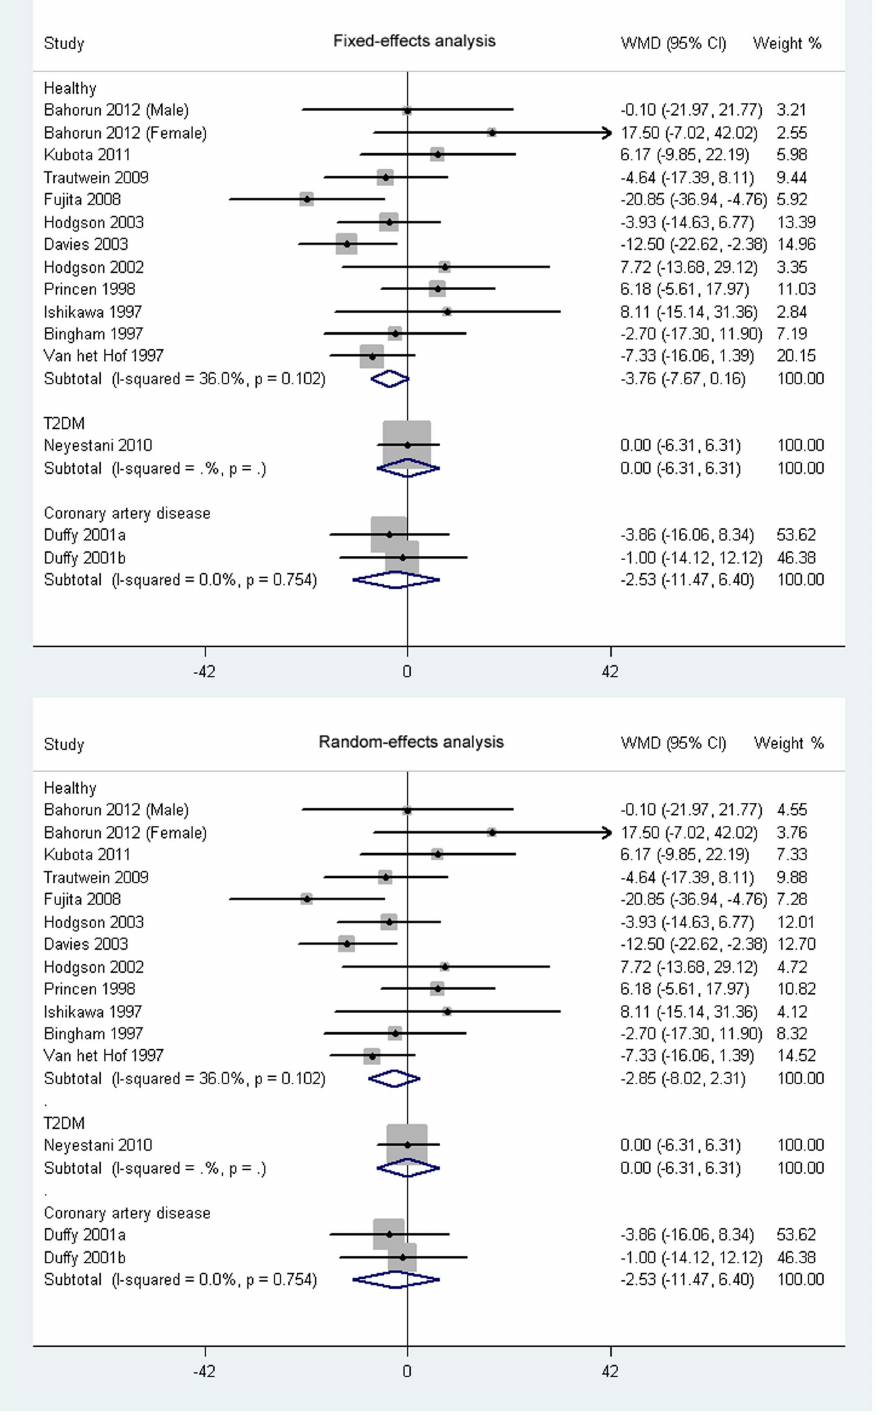
Figure 2. Meta-analysis of effects of black tea on concentrations of total cholesterol (TC). A meta-analysis was done with STATA software (Version 11; StataCorp, College Station, TX). Weight of each study was shown by sizes of data markers in the analysis. The diamond represents the overall estimated outcome and the results were calculated using a fixed-effects or random-effects model. WMD, weighted mean difference.